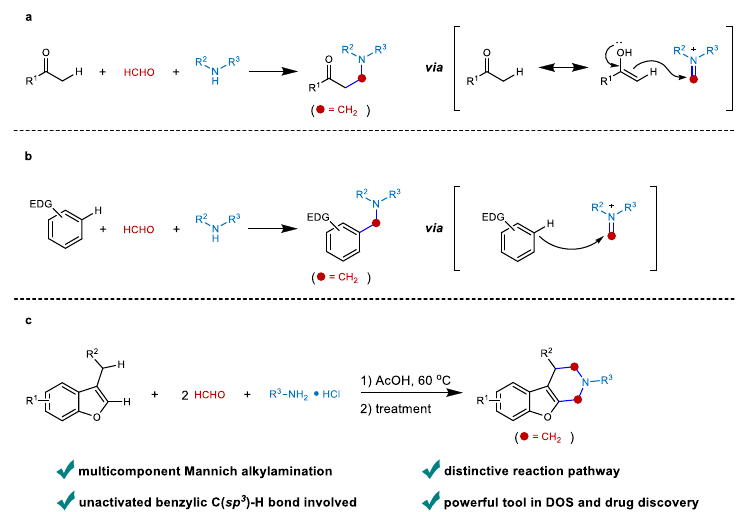
Fig. 1 Overview of Mannich reaction. a Classical Mannich reaction involving activated C(sp 3 ) − H bond. b Mannich reaction involving C(sp 2 ) − H bond of electron-rich arenes. c This work of double Mannich alkylamination for both C(sp 2 ) − H and unactivated benzylic C(sp 3 ) − H